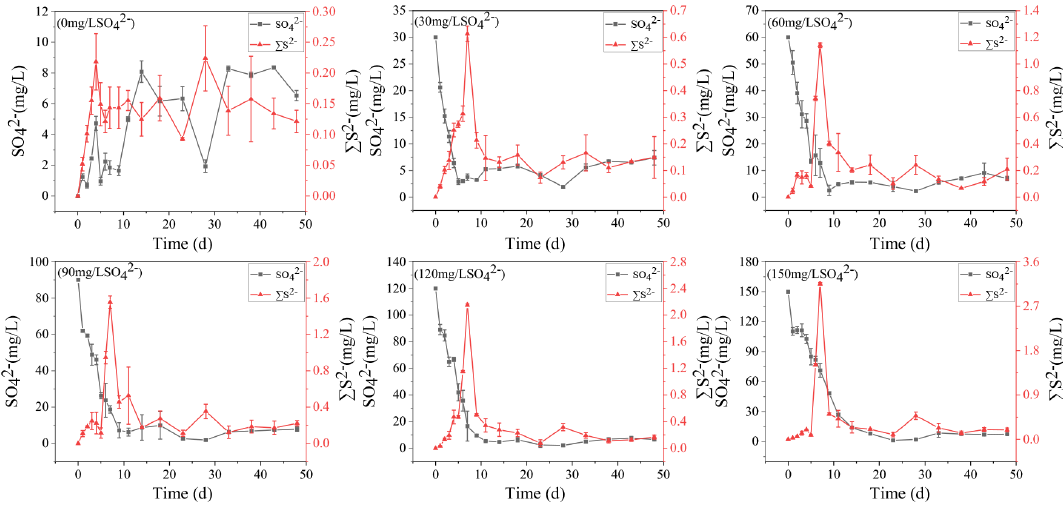
Figure 2. The concentration variations of SO 2 −